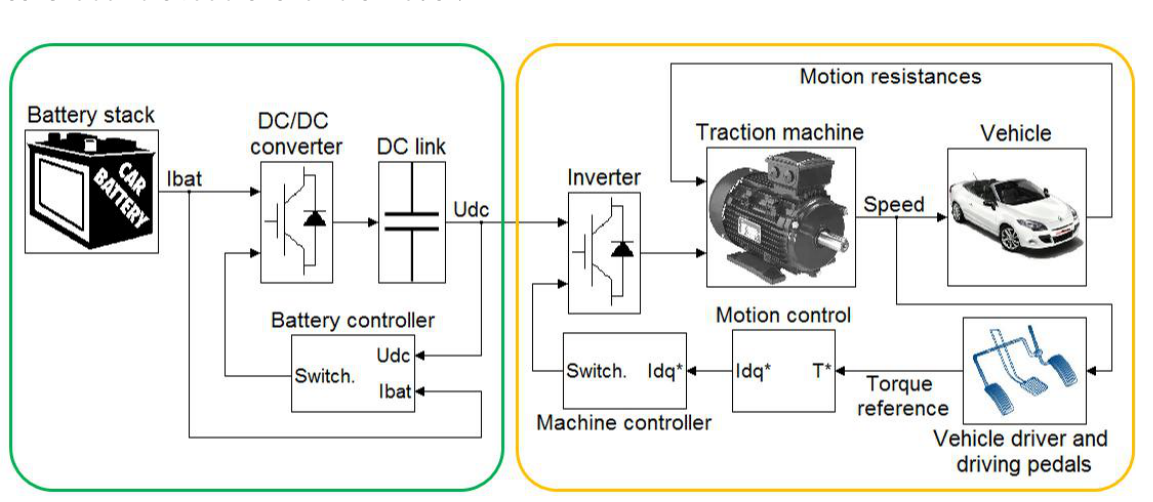
Figure 2. Simulation model (root level). Arrows represent either Simulink signals or SimPowerSystems